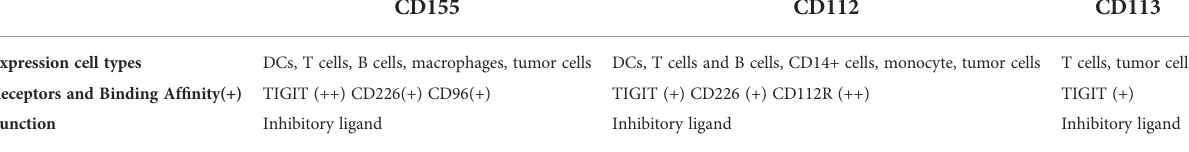
TABLE 3 Expression patterns of TIGIT ligands and their relative binding af fi nity and